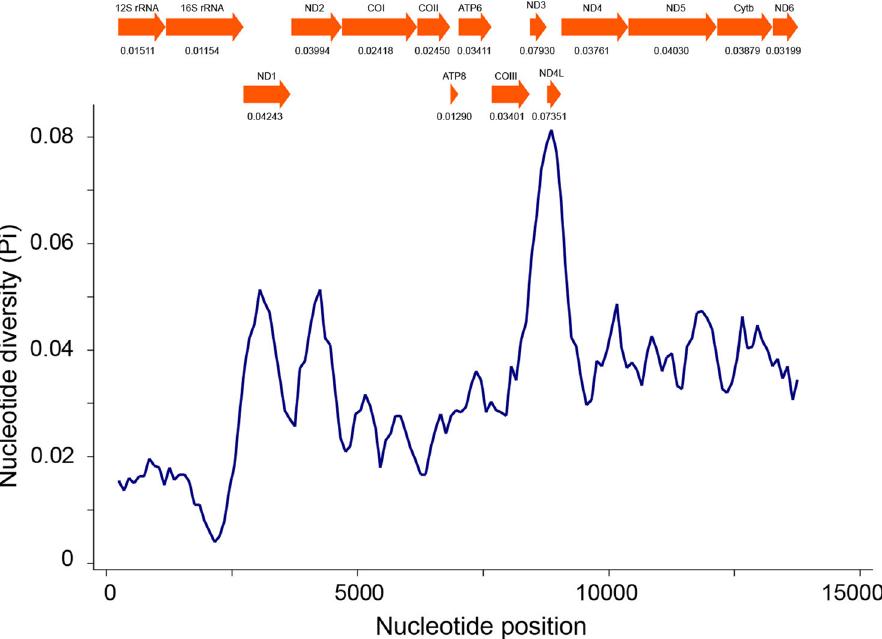
Figure 5. Sliding window analysis of PCGs and rRNA genes between four Aythya aves. The blue curve displays the value of nucleotide diversity (Pi). Each gene’s Pi value is displayed under the squares.